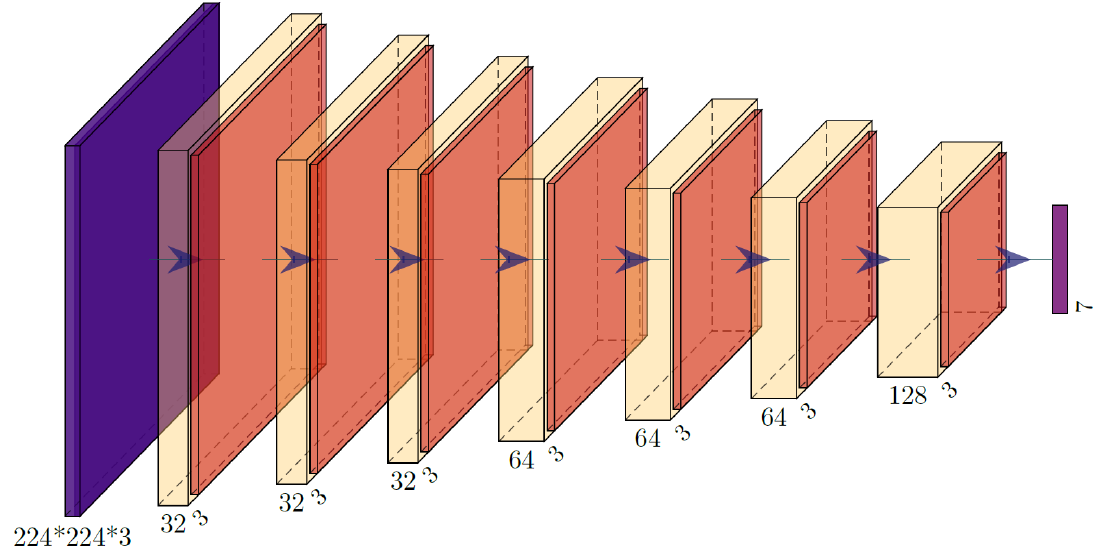
Figure 9. Proposed CNN architecture.